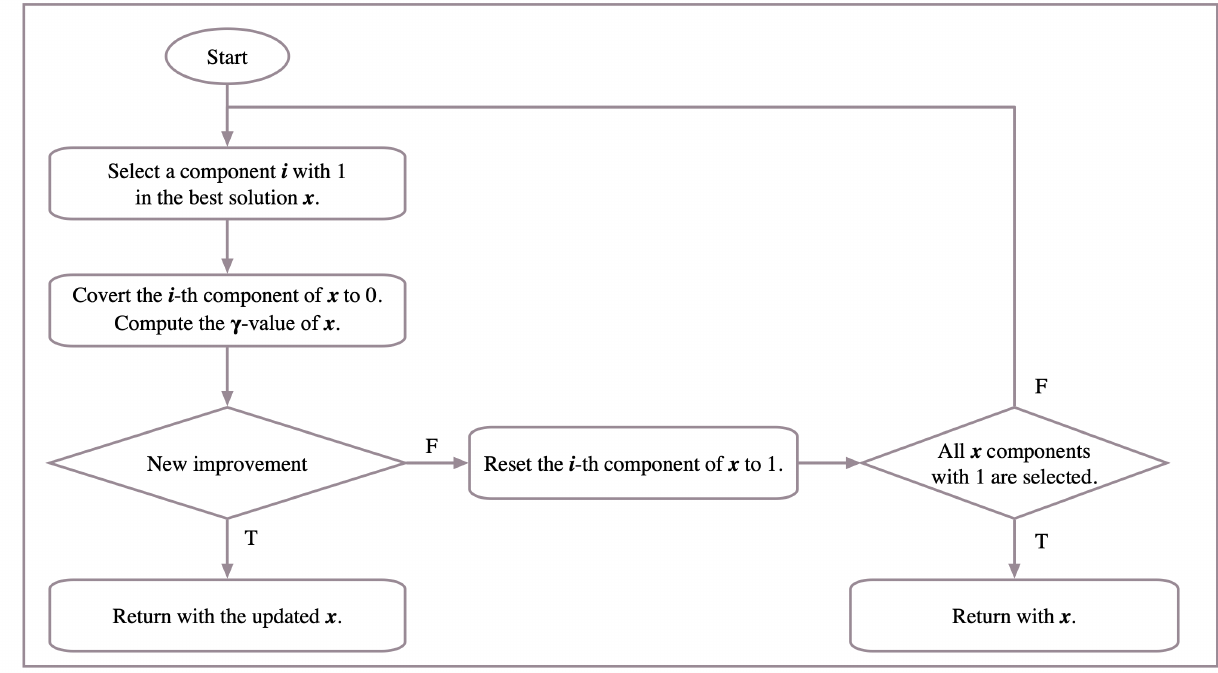
Figure 3. Reducing the cardinality of the best solution using the shaking